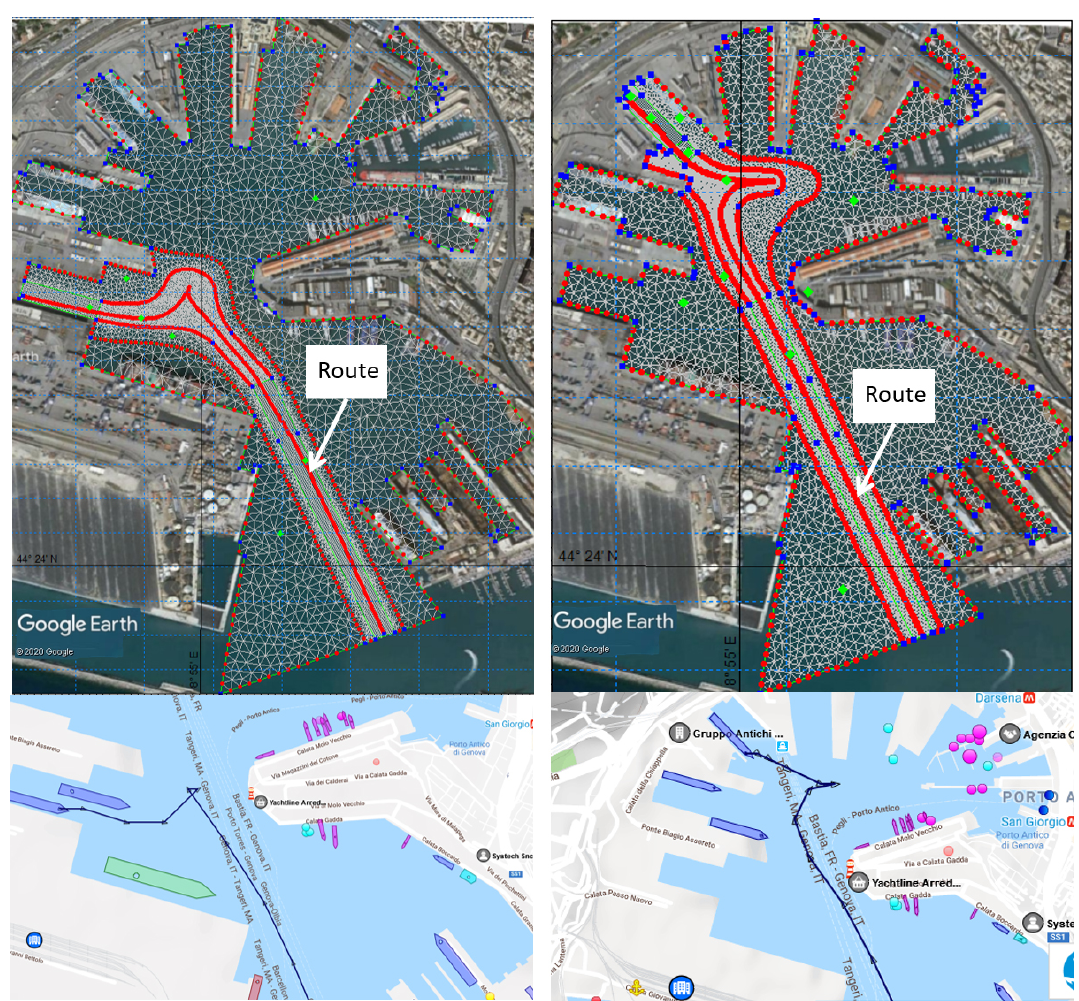
Figure 4. Model domain and computational grids for docking routes for the T1 (left panel) and T10 (right panel) docks. In the lower panels, the corresponding actual routes are shown. Land background of the upper panels is from © Google